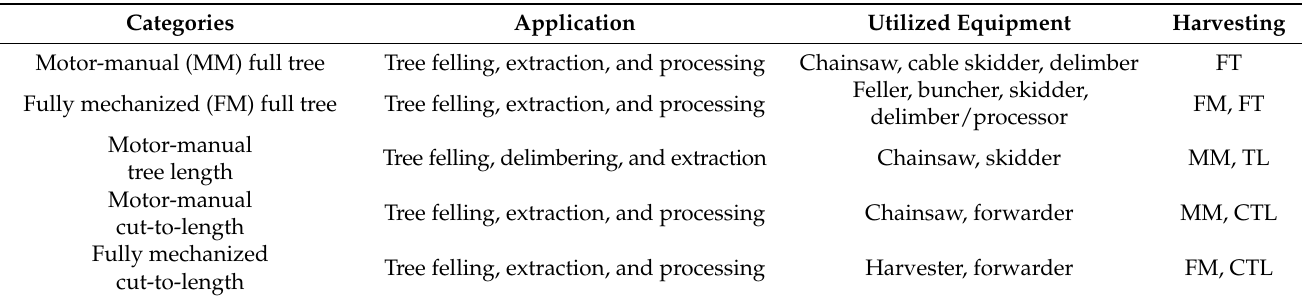
Table 2. Harvesting systems for various mechanization levels and